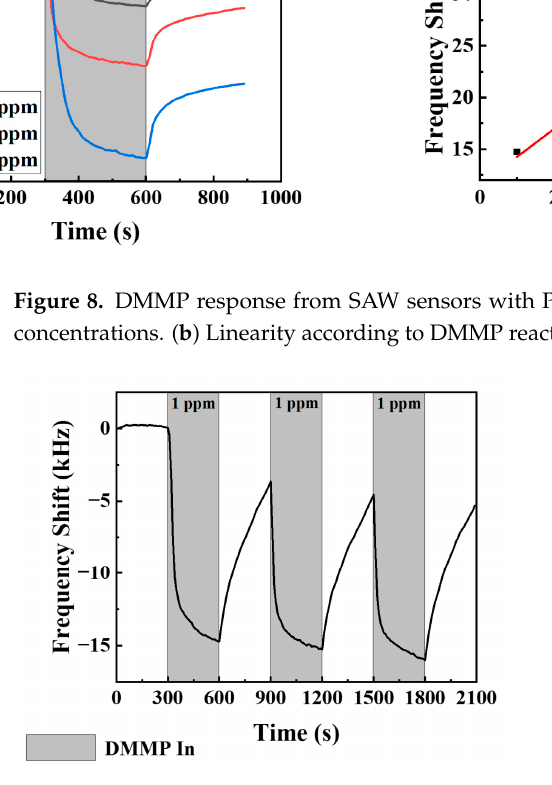
Figure 9. The repeatability of the SAW sensor at a DMMP concentration of 1 ppm.